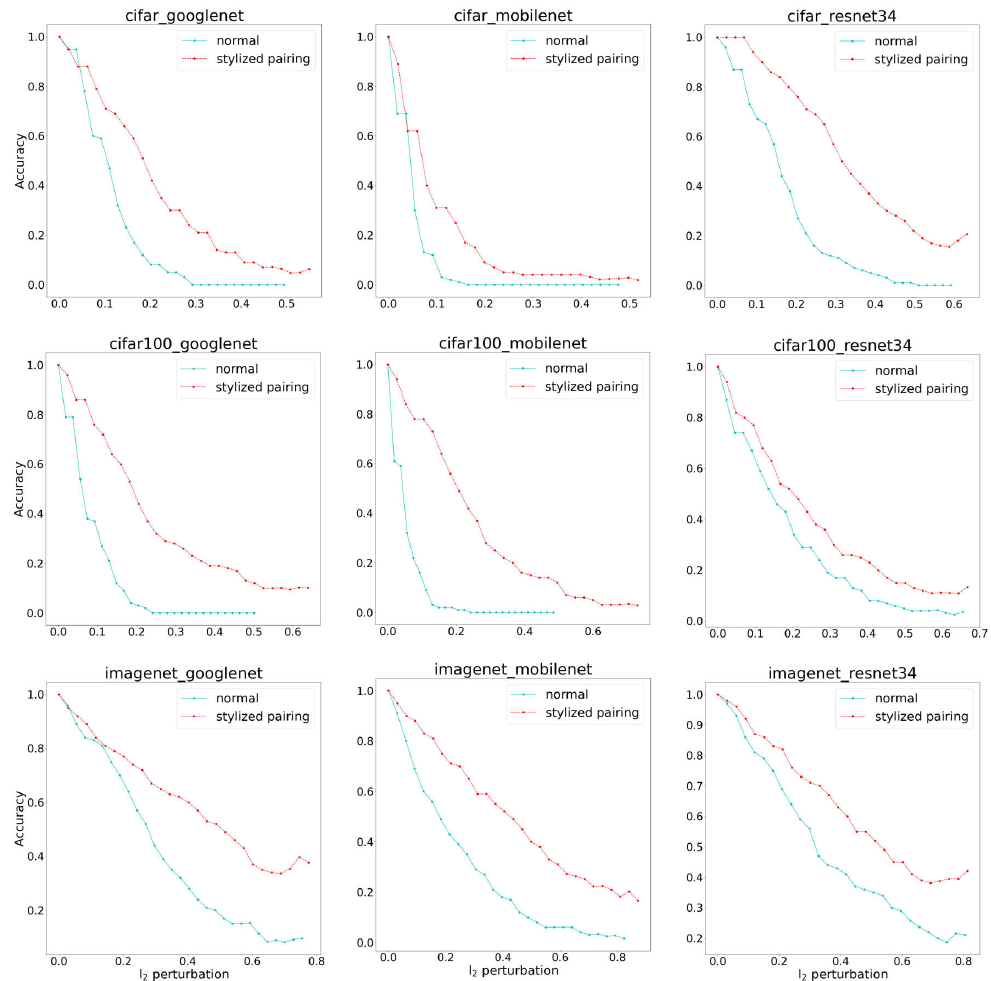
Figure 3. The average adversarial accuracy of a set of 100 test images with respect to different perturba- tion strengths imposed by the Fast Gradient Sign